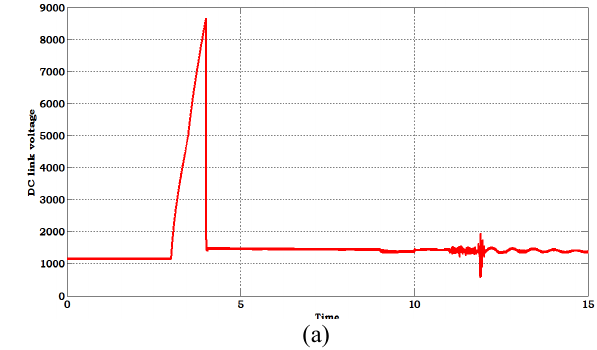
Figure 10. (a). DC link voltage, (b).Frequency There is sudden change in DC link voltage at t=3 sec but controller brings back voltage and frequency in constant. Test Case 3: when operating system in grid connected mode with sudden connection of other